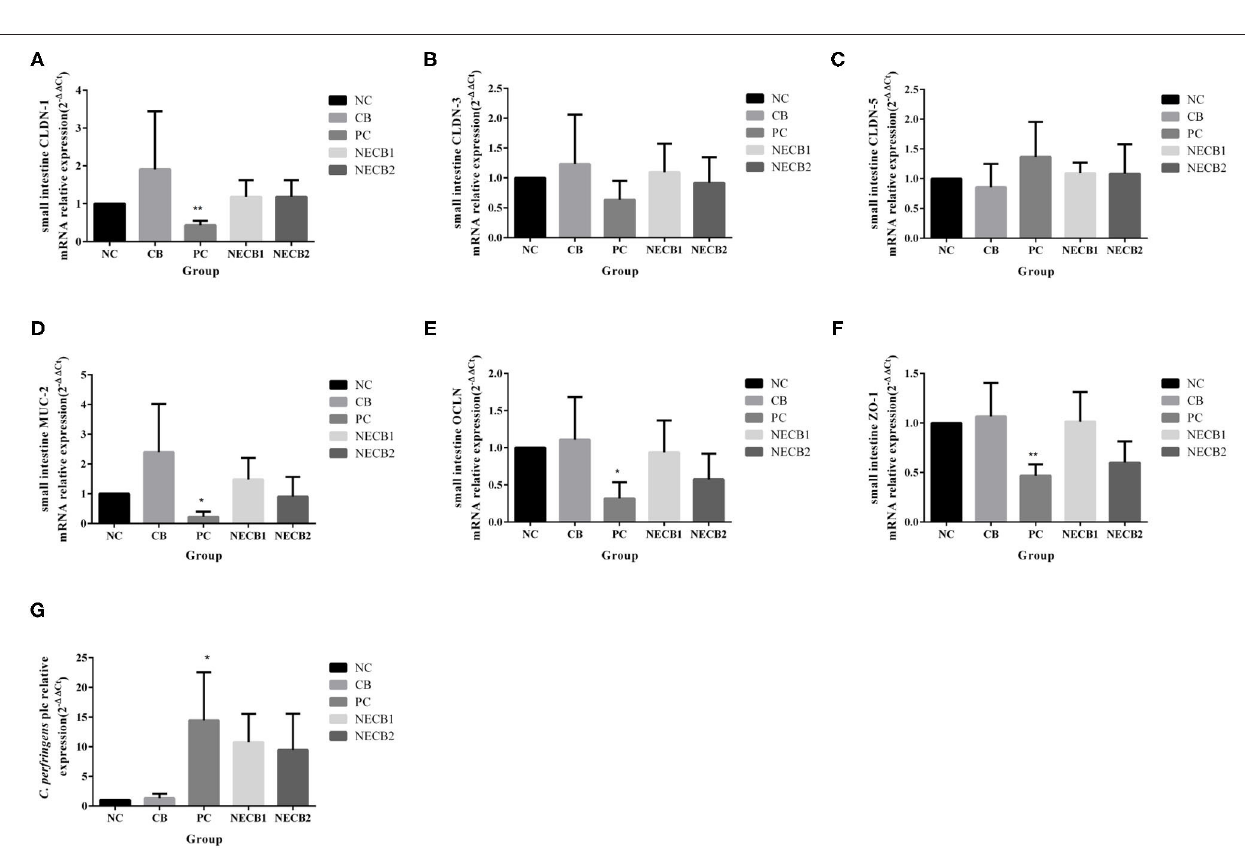
FIGURE 4 | Relative mRNA expression intestinal barrier function-related in the small intestine and Clostridium perfringens plc gene in small intestine contents. (A) CLDN-1. (B) CLDN-3. (C) CLDN-5. (D) MUC-2. (E) OCLN. (F) ZO-1. (G) CPplc. Each result represents the mean ± SEM ( n = 3). *Represent p < 0.05, **represent p <